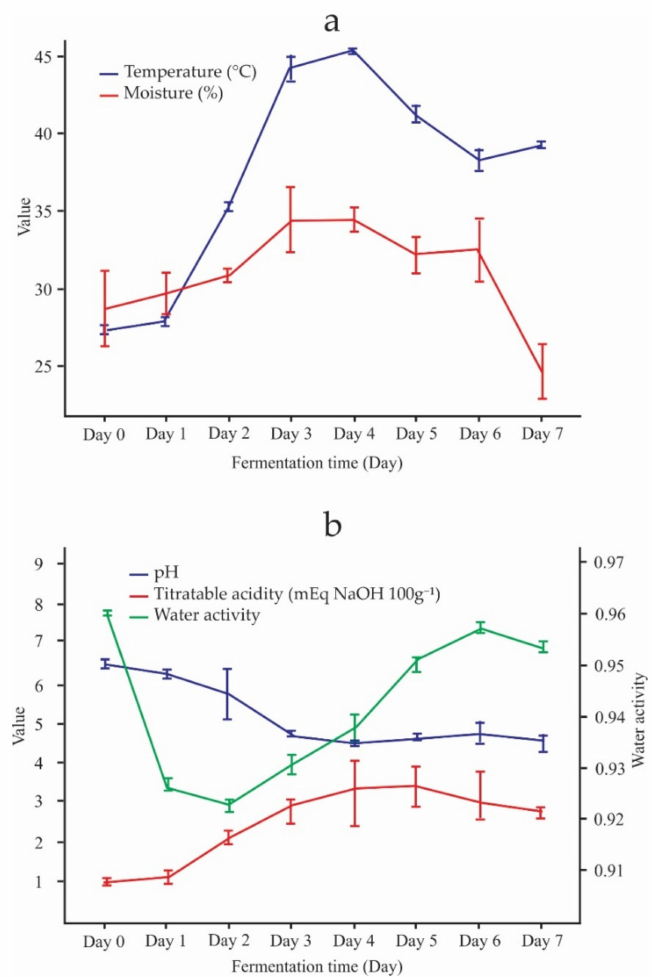
Figure 1. Evolution of spontaneous fermentation parameters of Criollo cocoa beans. ( a ) Evolution of temperature and moisture, ( b ) Evolution of pH, titratable acidity and water